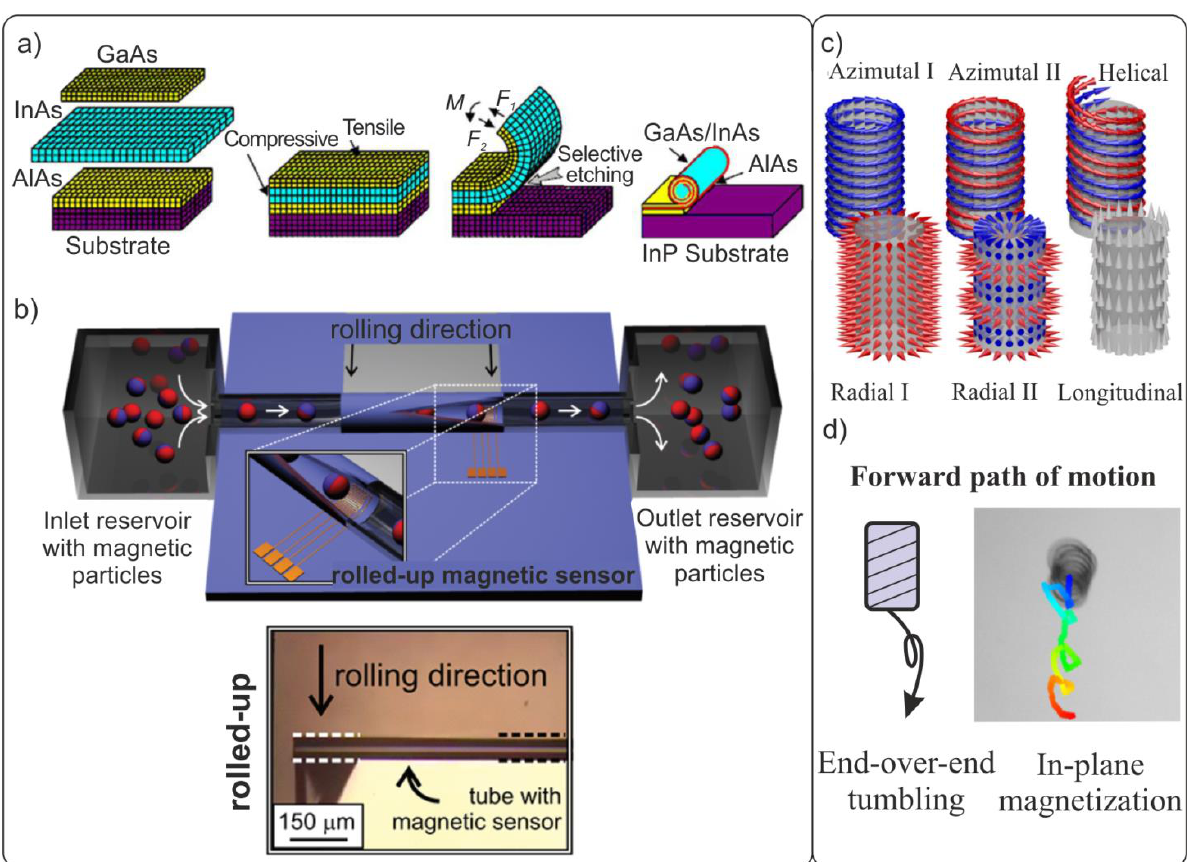
Figure 7. ( a ) Stages in the formation of arrays of rolled-up semiconductor and polymer 3D shells. The rolling of strained films in a tube scroll occurs after their separation from the substrate by selective liquid etching [13]. ( b ) Schematic representation of a rolled-up multilayer GMR sensor for the in-flow detection of magnetic objects inside a microfluidic channel [124]. Copyright 2011, American Chemical Society. ( c ) Domain structure in bent cylindrical films. Reproduced from [121], © IOP Publishing. Ltd. All rights reserved. Top row: circular magnetization without a longitudinal component (azimuthal) and with a longitudinal component (helical). Bottom row: radial and longitudinal magnetization. ( d ) Tracking the trajectory in magnetic field of a rolled-up magnetic coil with in-plane magnetization [125].